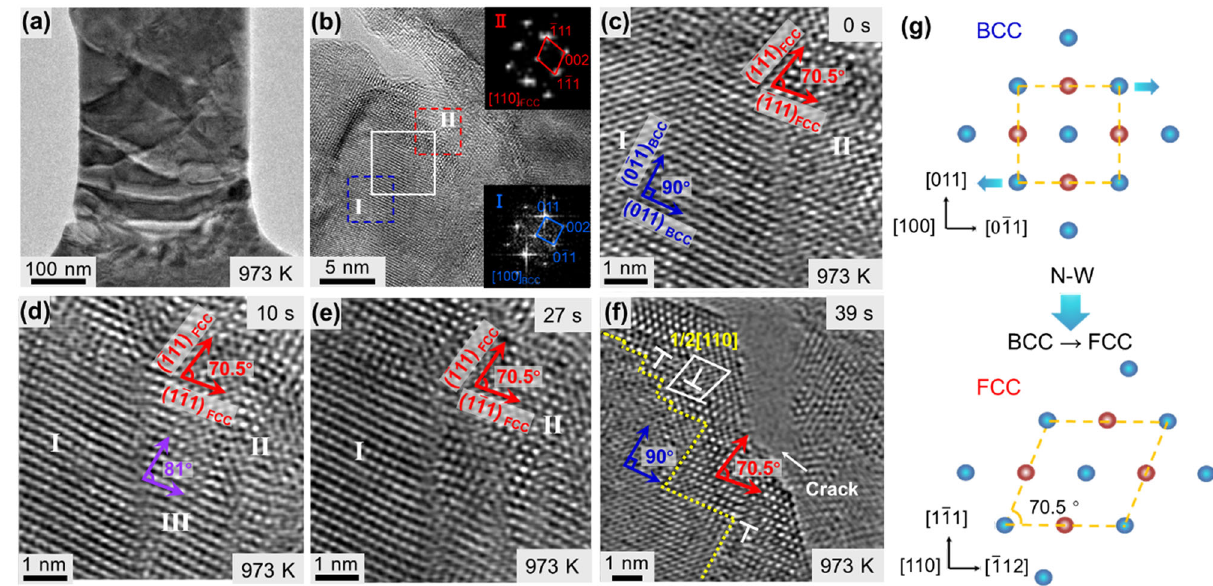
Fig. 3 HRTEM observation of strain-induced BCC-FCC phase transformation. a A TEM bright- fi eld image of the sample at the moment when a crack was initiated upon tensile deformation at 973 K. b A HRTEM image of the region around the crack tip. The insets are two Fast-Fourier Transform patterns of two areas (red dashed box and blue dashed box) in this region. c – f Time-resolved HRTEM images of the region within the white box in b showing BCC-FCC phase transformation at the crack tip at 973 K. Region I marked with the blue basic lattice vectors is [100] BCC zone axis. Region II marked with the red basic lattice vectors is [110] FCC zone axis. Region III marked with the purple basic lattice vectors is intermediate phase. g A crystallographic schematic of the BCC-FCC phase transformation by habit plane shear of the